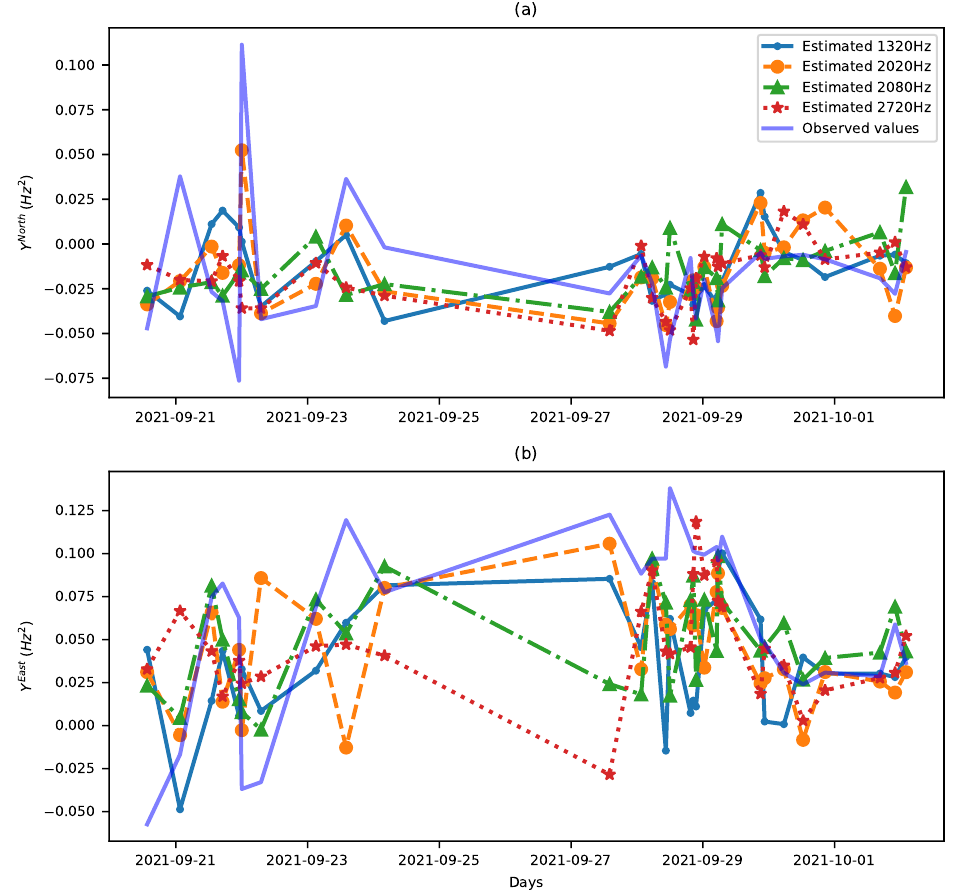
Figure 9. Comparison of 4 XGBoost regression models equipped by 20 decision trees of the max depth 10 utilizing features for different frequencies to estimate the projections of the effective wavenumber, namely: ( a ) the North projection and ( b ) the East